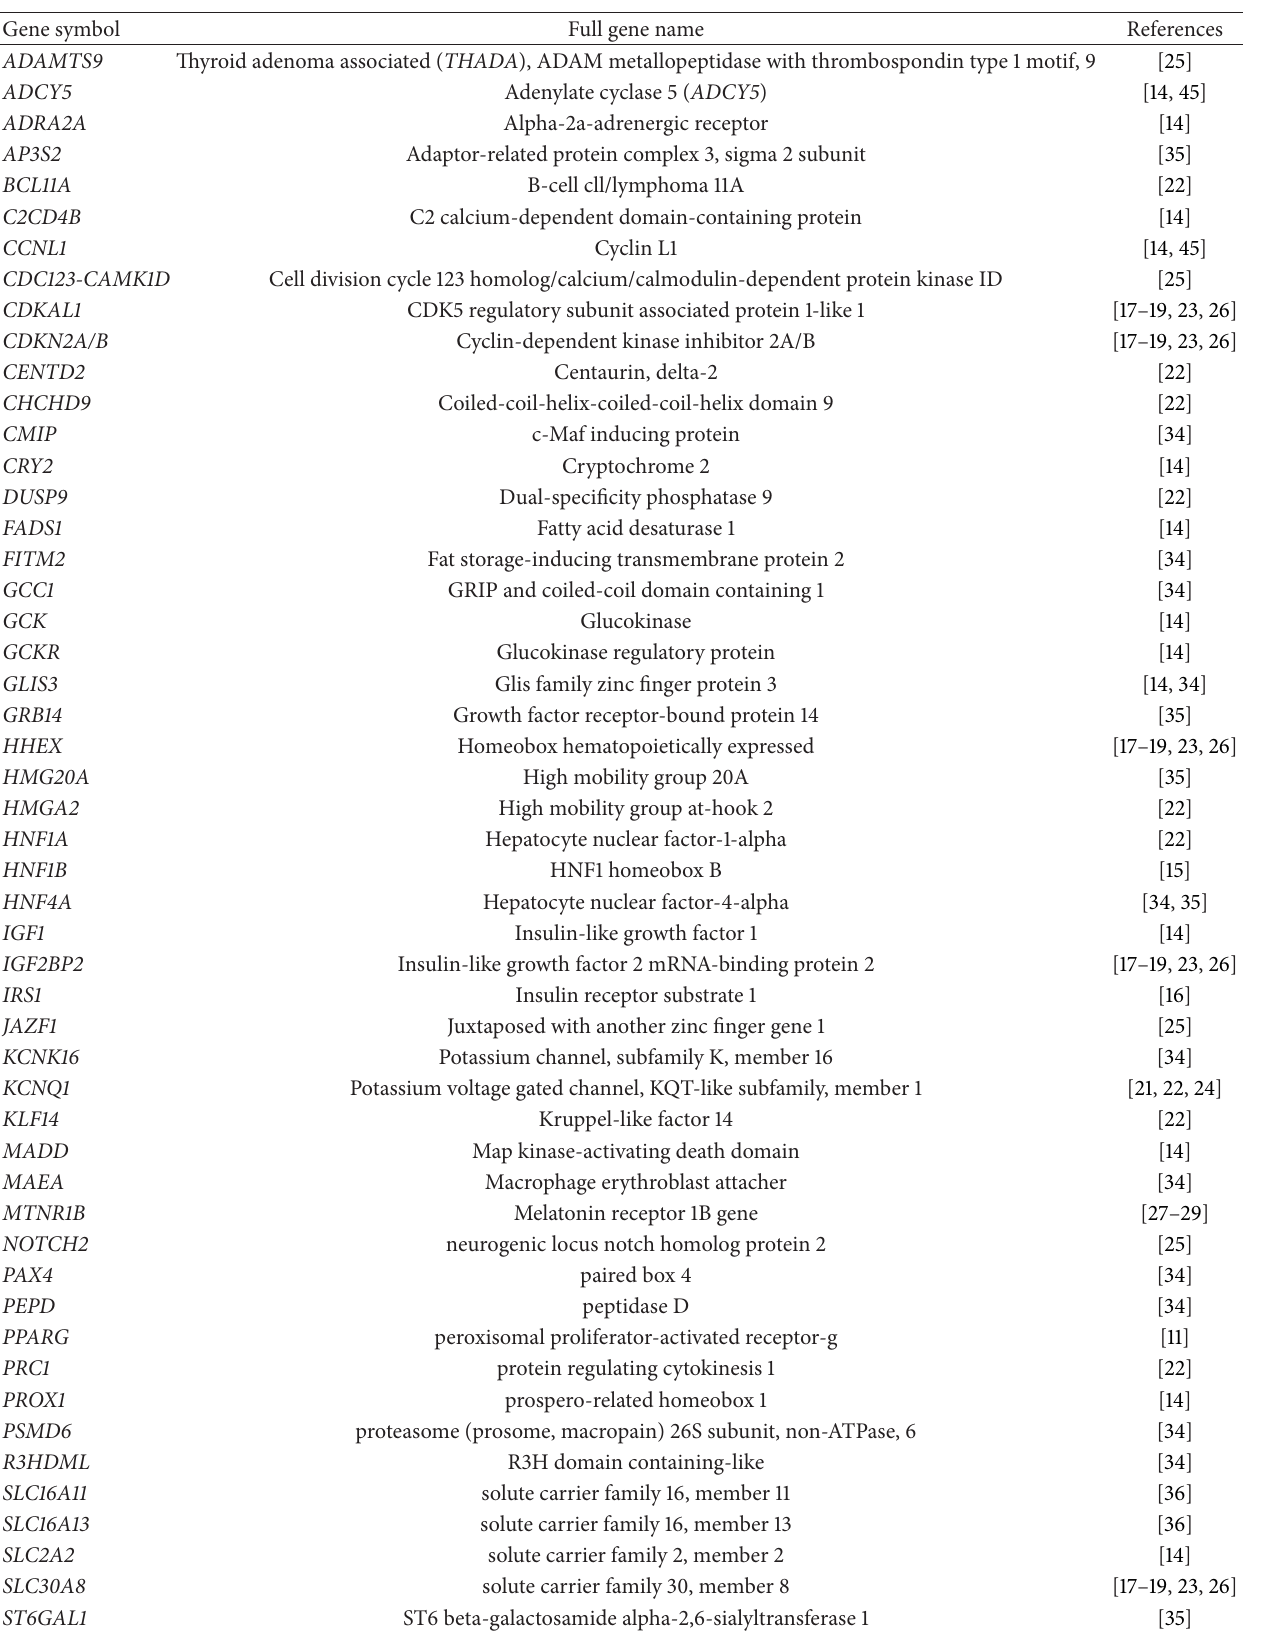
Table 1: Type 2 diabetes loci established to